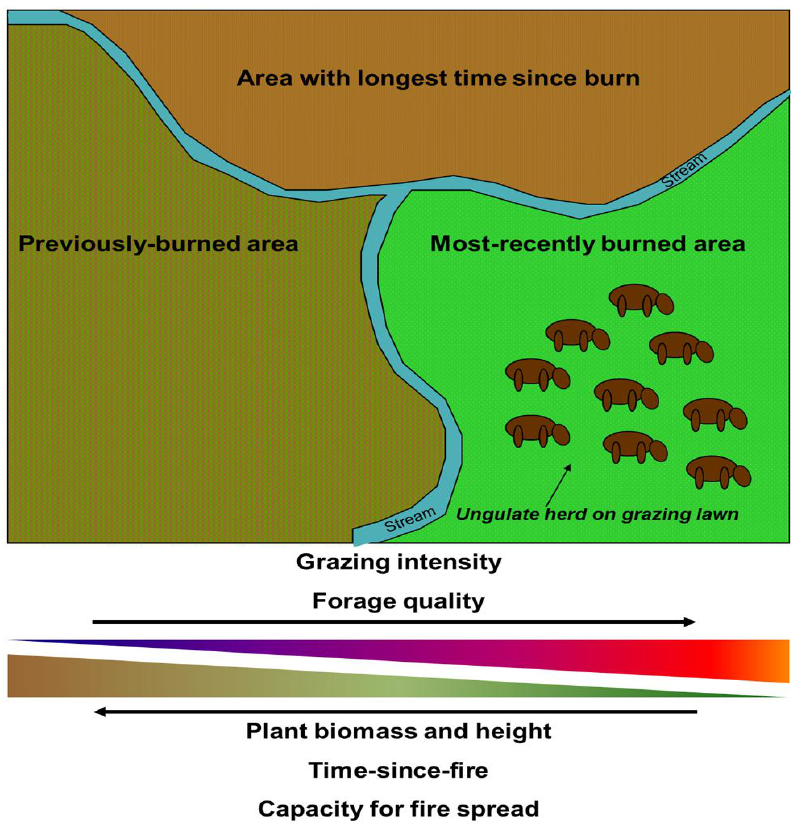
Figure 1. A spatially- and temporally-heterogeneous landscape mosaic created by the fire-grazing interaction. Spatially-patchy fire drives the spatial distribution of grazing, causing herbivores to congregate in the most-recently-burned patch. Meanwhile, other patches in the landscape remain ungrazed and accumulate fuel, increasing their probability of burning under future ignitions. Meanwhile, the heterogeneity in vegetation structure created by patches with different time-since-fire creates a mosaic of wildlife habitat. While not all animal activity will be concentrated in the burned area because animals must move about the landscape for water, security, or micronutrients, research shows that animals select recently-burned areas more than any other resource or position in the landscape